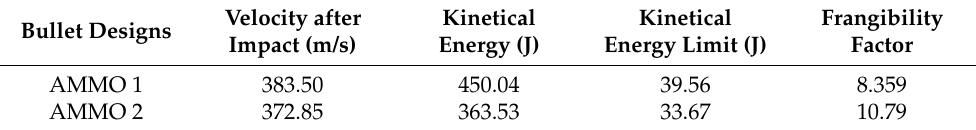
Figure 8. Frangibility factor value comparison graph. Table 5. Projectile kinetical energy and frangibility factor.